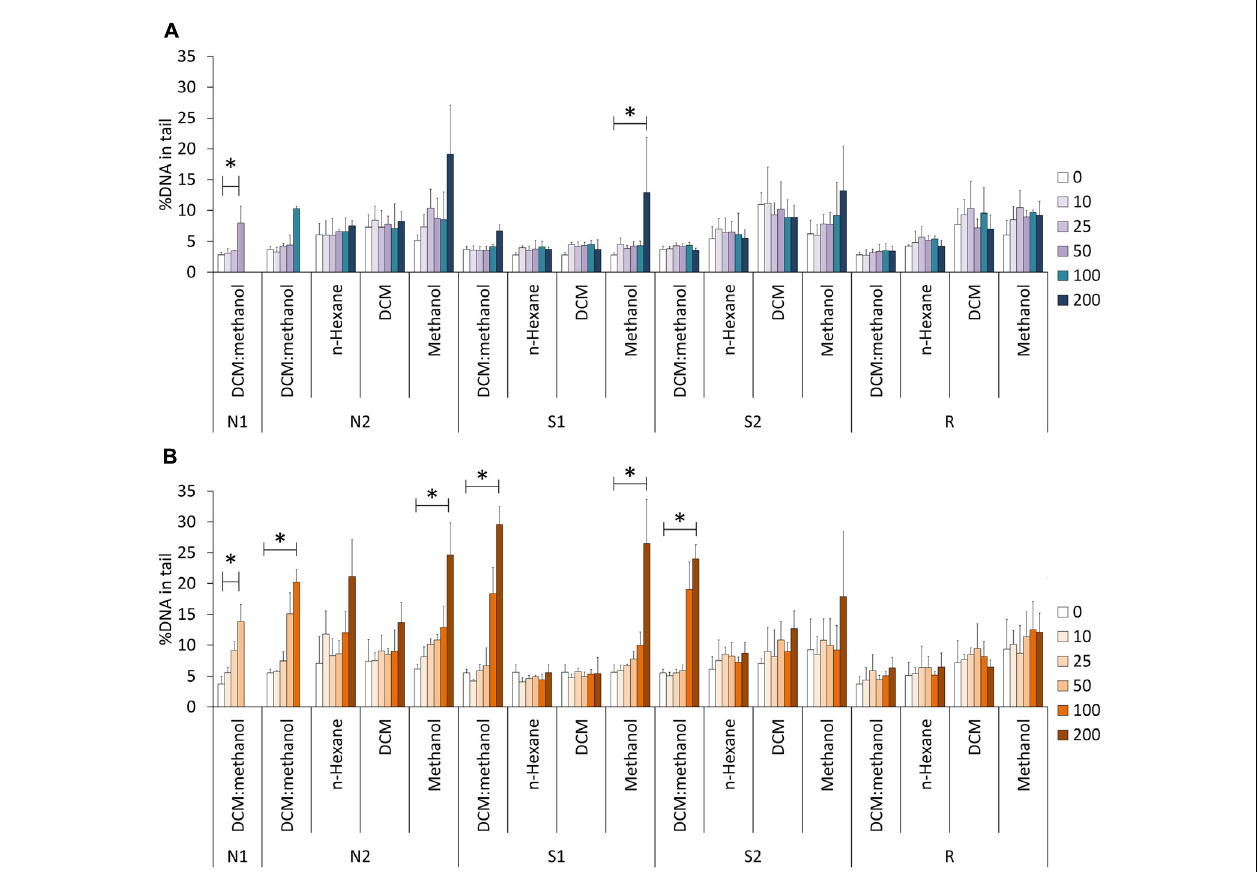
FIGURE 3 | Comet assay results in HepG2 cells exposed to the different sediment extracts at different concentrations (0–200 SEQ mg/mL). (A) Experiments without FPG treatment. (B) Results from the FPG-linked Comet assay. *Indicates significant differences between multiple